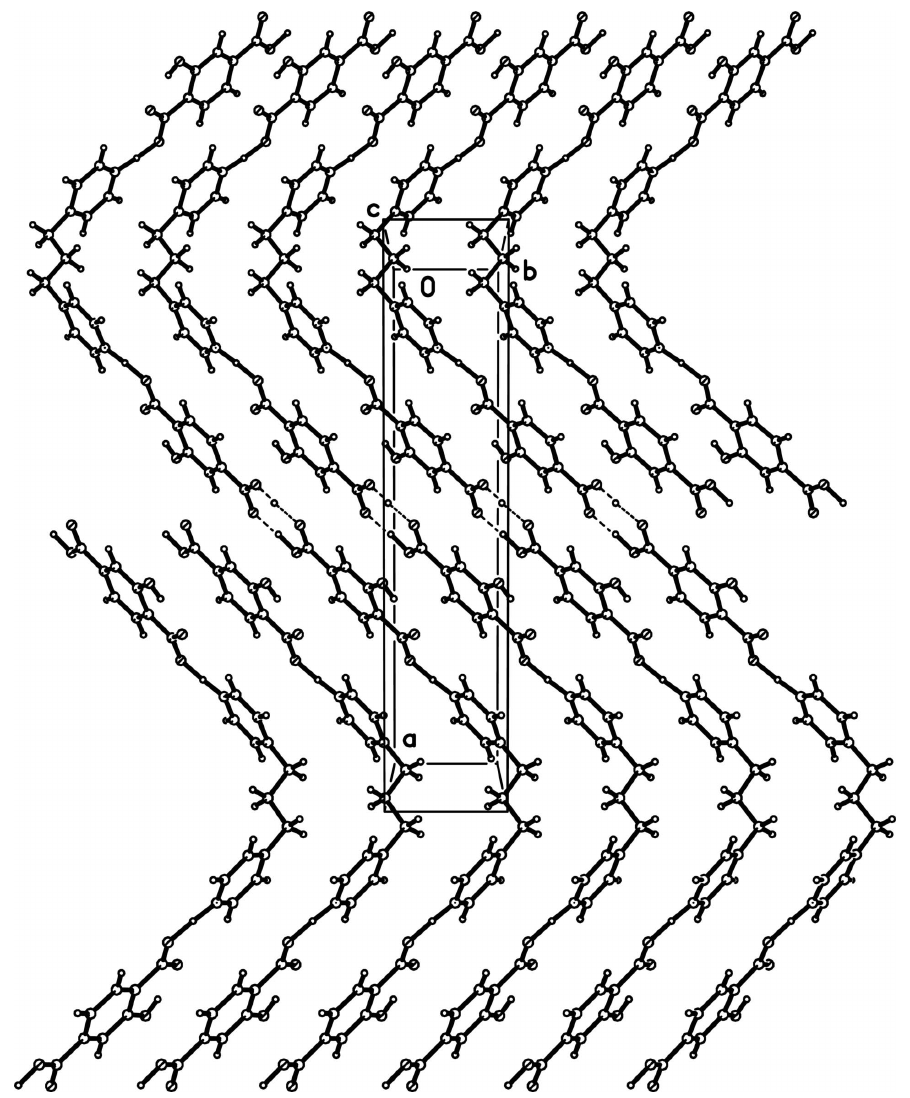
The unit-cell packing of the title compound, showing the hydrogen bonding